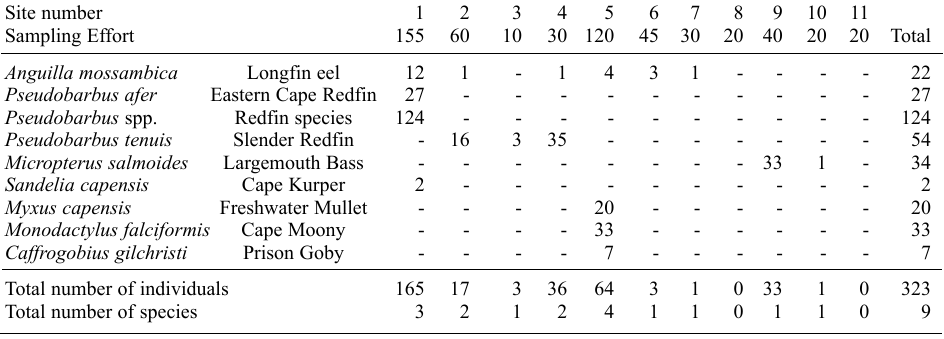
Number of fish specimens per species collected per site in the Tsitsikamma National Park during February and March 2001. Site numbers as per Figure 1. Sampling effort = minutes electro-fishing Site